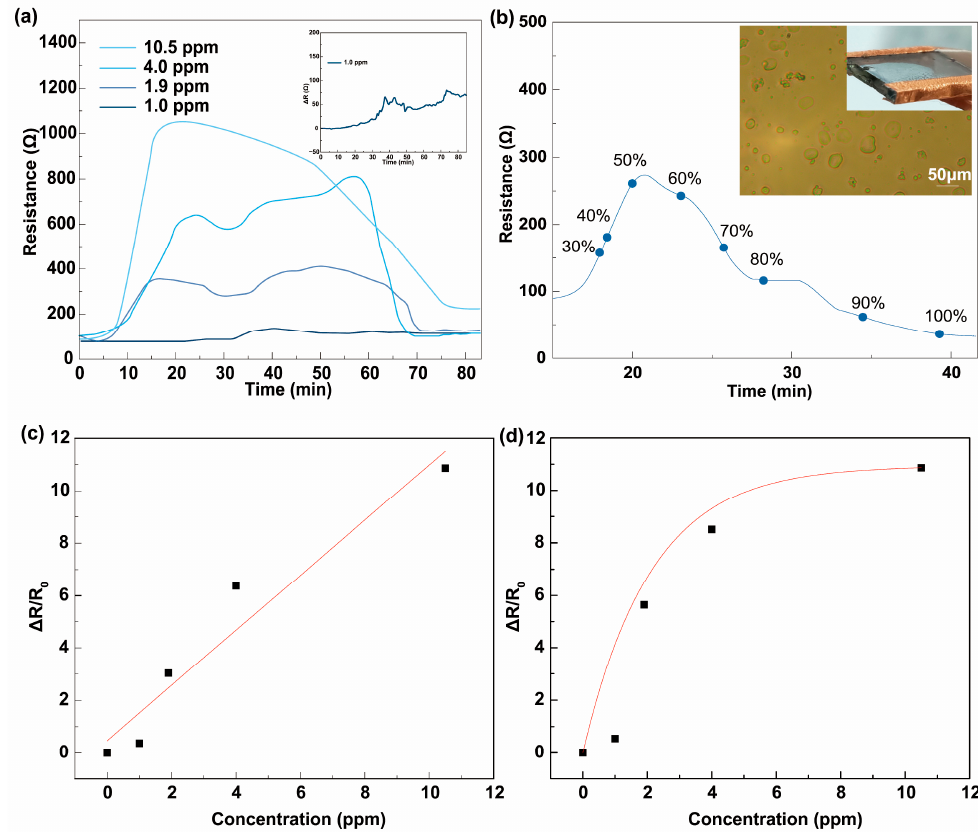
Figure 2. ( a ) Resistance-time curves of PEDOT:PSS films in different concentrations of HPV. Inset: resistance change-time curve of PEDOT:PSS film to 1.0 ppm HPV. ( b ) Resistance-time curve of PEDOT:PSS film under increasing ambient humidity (30% RH–100% RH), inset: optical microscope image of PEDOT:PSS film at high humidity, where the moisture could be condensed into droplets on the film surface. Resistance response-HPV concentration fitting curve of PEDOT:PSS films: ( c ) R = the first resistance peak, ( d ) R = the highest resistance peak.